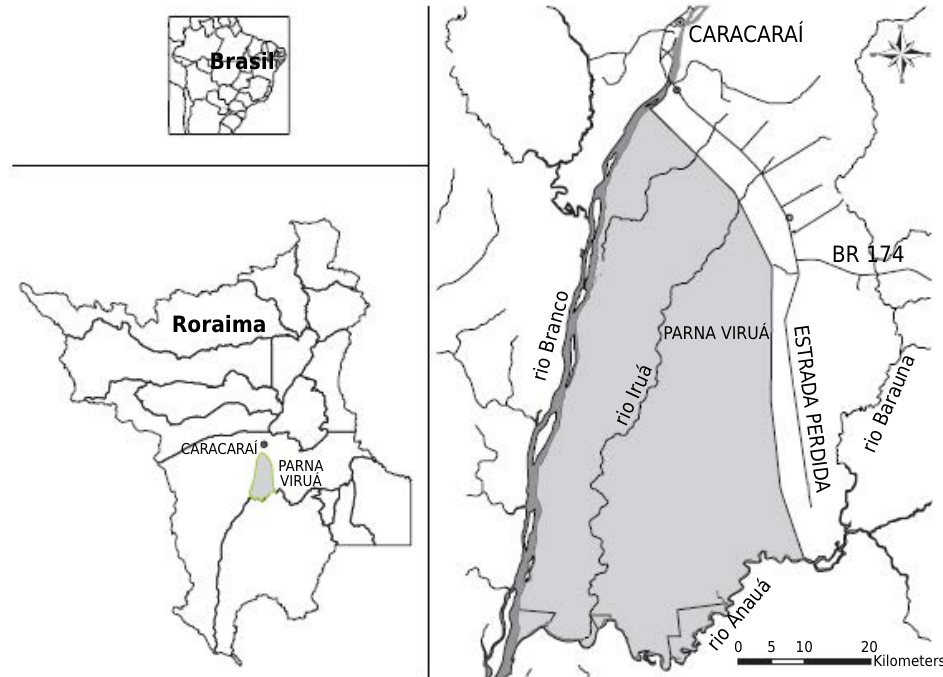
Figure 1. Localization of Viruá National Park in the state of Roraima,